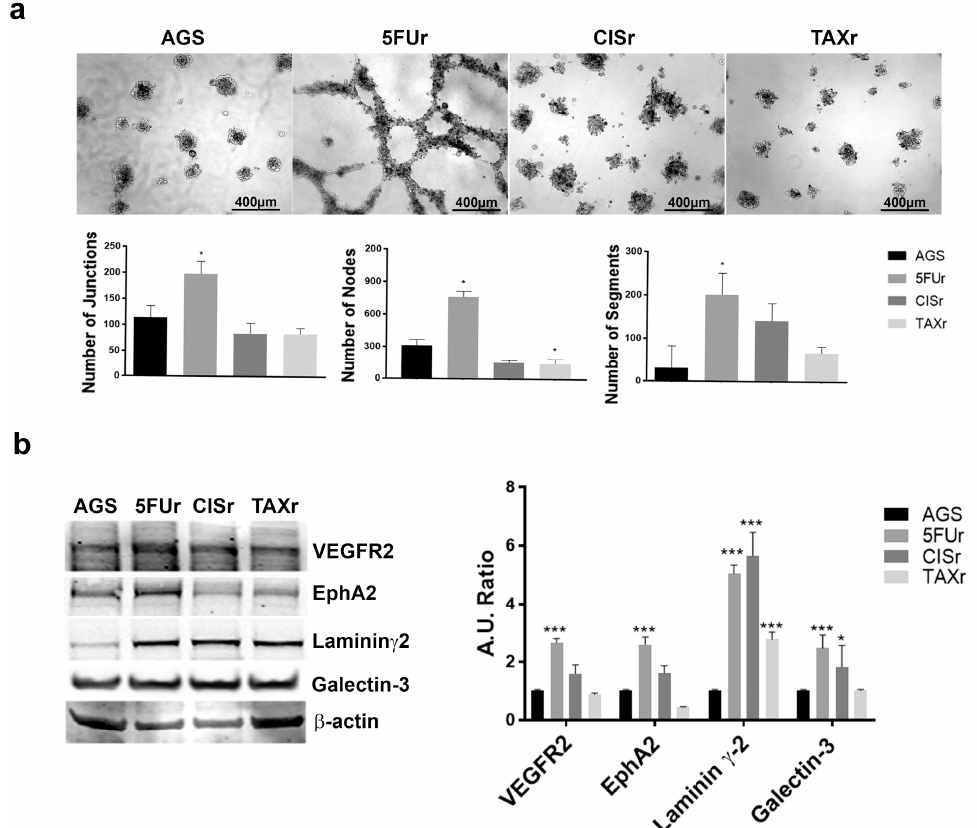
Figure 3. 5FUr cells enhanced vasculogenic capability. ( a ) AGS WT and chemoresistant cells were plated on Matrigel and pictures were taken after 24 h. The representative images and the number of Junctions, Nodes and Segments of tubes are presented. Images were captured at 10X magnification—scale bar 400 µ m. ( b ) Whole-cell lysates were analyzed by Western Blot for VM-related markers expression. β -Actin was used as a loading control. Densitometric analysis was performed using ImageJ software. Data are presented as mean ± SD ( n = 3). * p < 0.01; *** p < 0.0001 (Two-way ANOVA